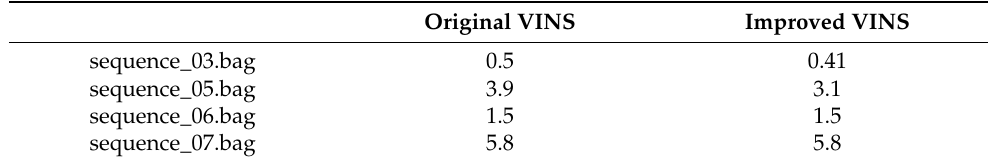
Table 7. The Absolute Pose Error (APE) of the original algorithm is compared with that of the improved algorithm in the underwater dataset. (Unit: meter).